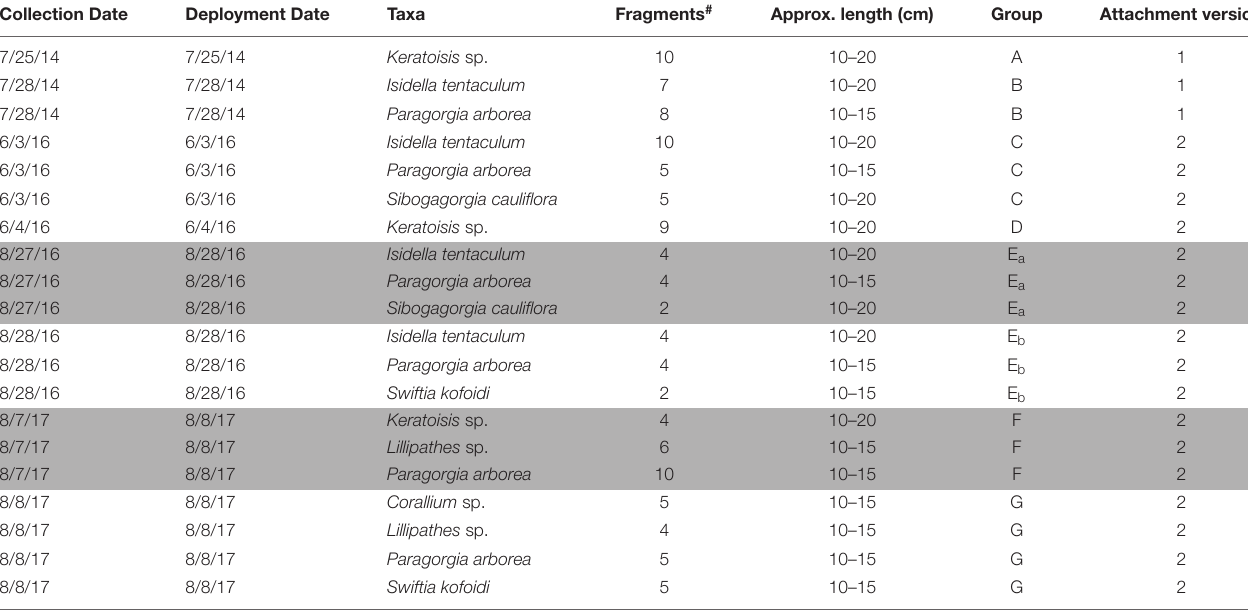
TABLE 1 | Metadata for deep-sea coral translocation